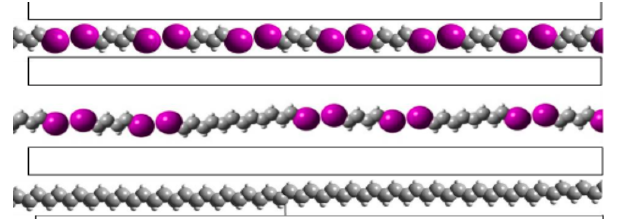
frequencies for polyacetylene fundamental transitions and their overtones.